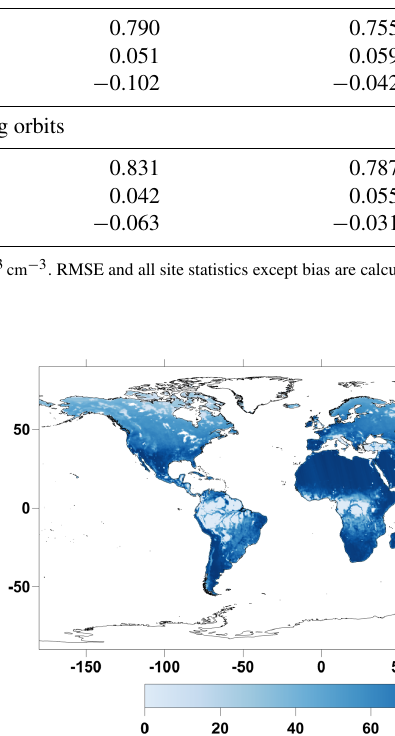
Figure 10. Temporal frequency distribution map of estimated high- quality (QC) retrievals, which exclude areas with dense vegetation (VOD > 2.3), saturated microwave signals (V-pol and H-pol T b dif- ference at 18 or 23GHz less than 1.0K), and large water bodies (FW >